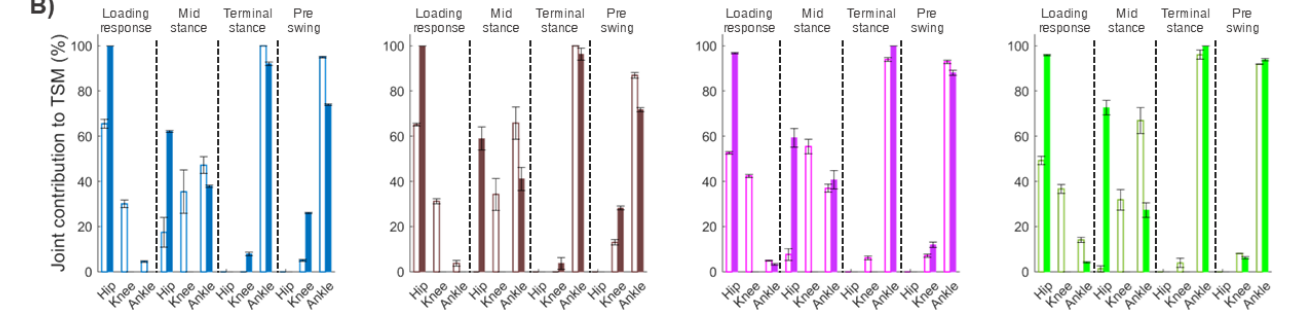
Figure 5. ( A ) Mean total support moment at the four conditions during the entire stance phase. ( B ) Individual joint contributions to total support moment as a function of the sub-phases of the stance phase. Results of the amputated leg (AL) are presented in filled bars, and that of the unaffected leg (UL) are presented in bars with colored borders: Variflex (blue), Meridium (brown), Echelon (magenta), and Kinterra (green).